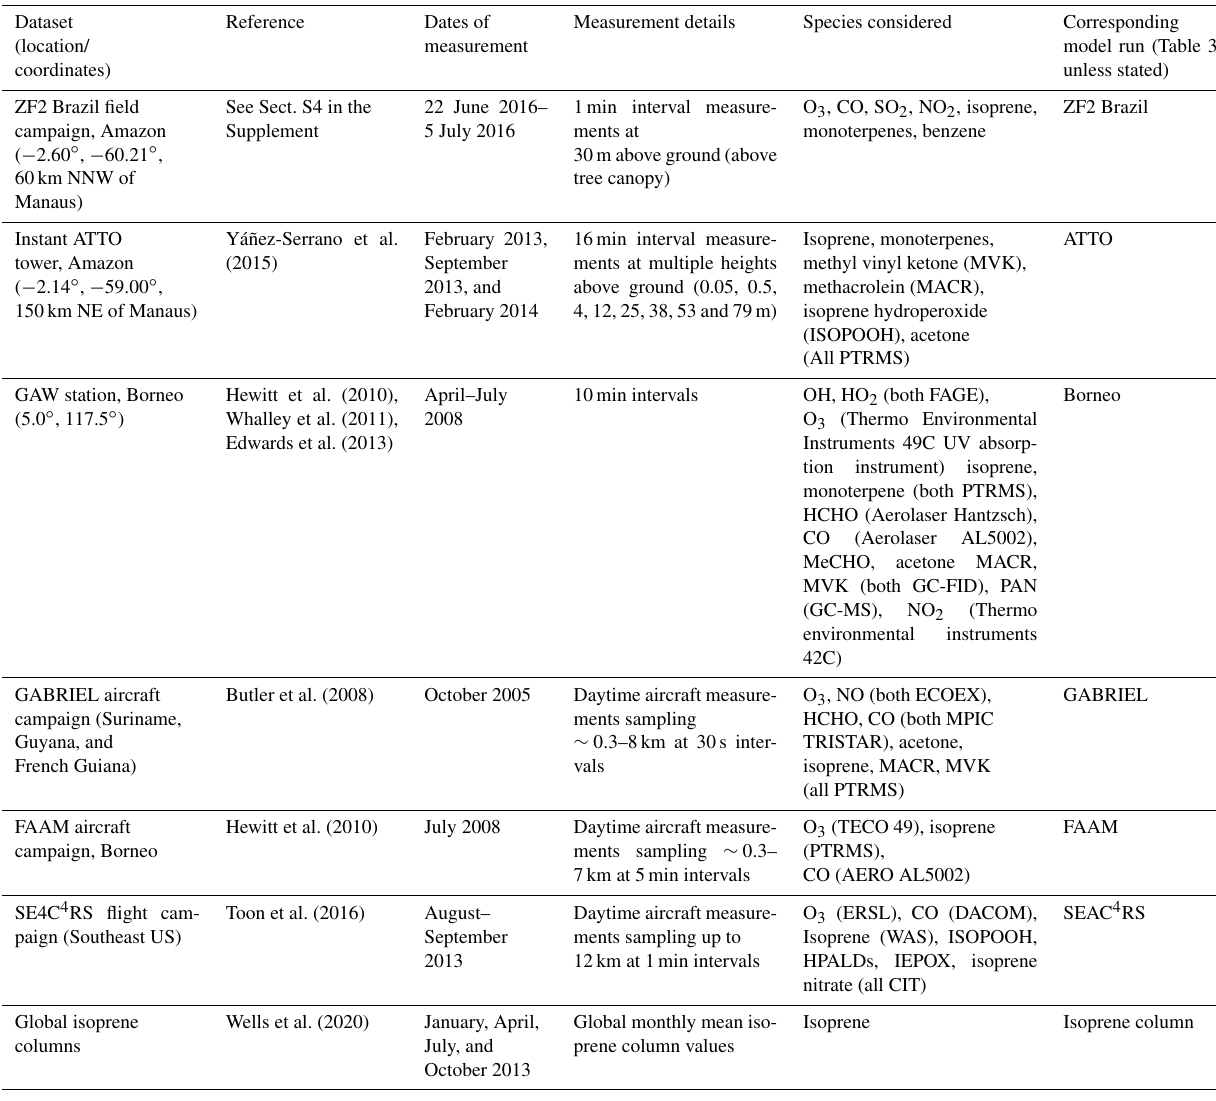
Table 5. Location, reference, time period, and species measured in observational data sets and the corresponding modelling approach. For the ZF2 Brazil, ATTO, Borneo, GABRIEL, FAAM and SE4C 4 RS data sets, model data was filtered to select only the same days as observational